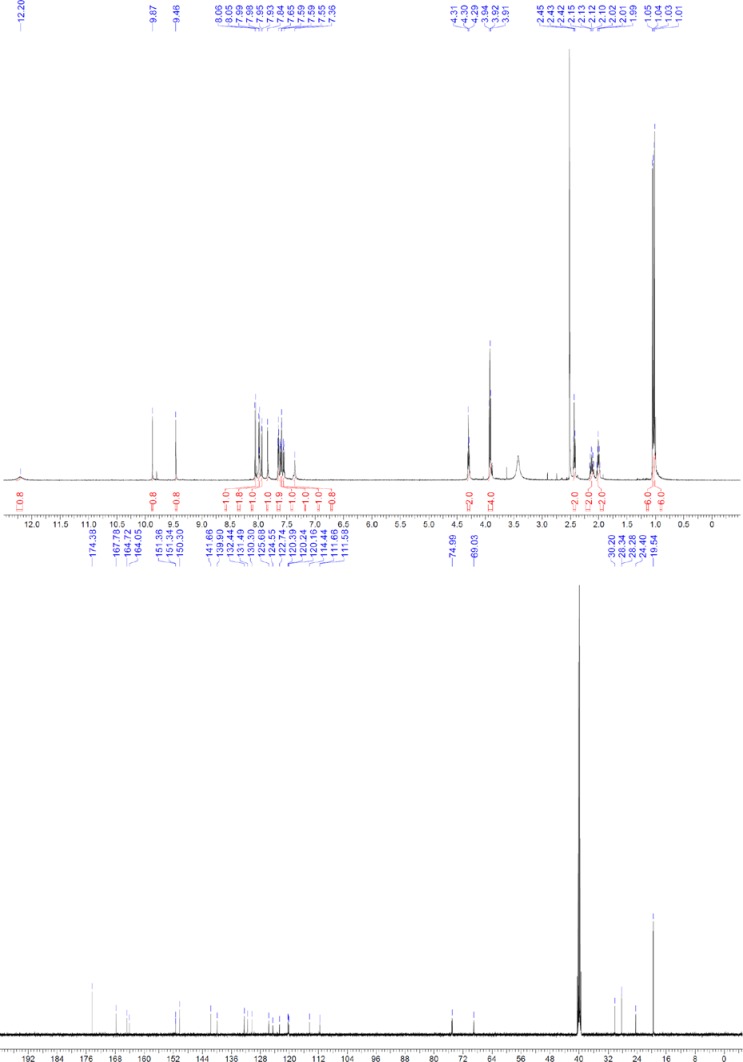
1H and 13C NMR of ERX-10.